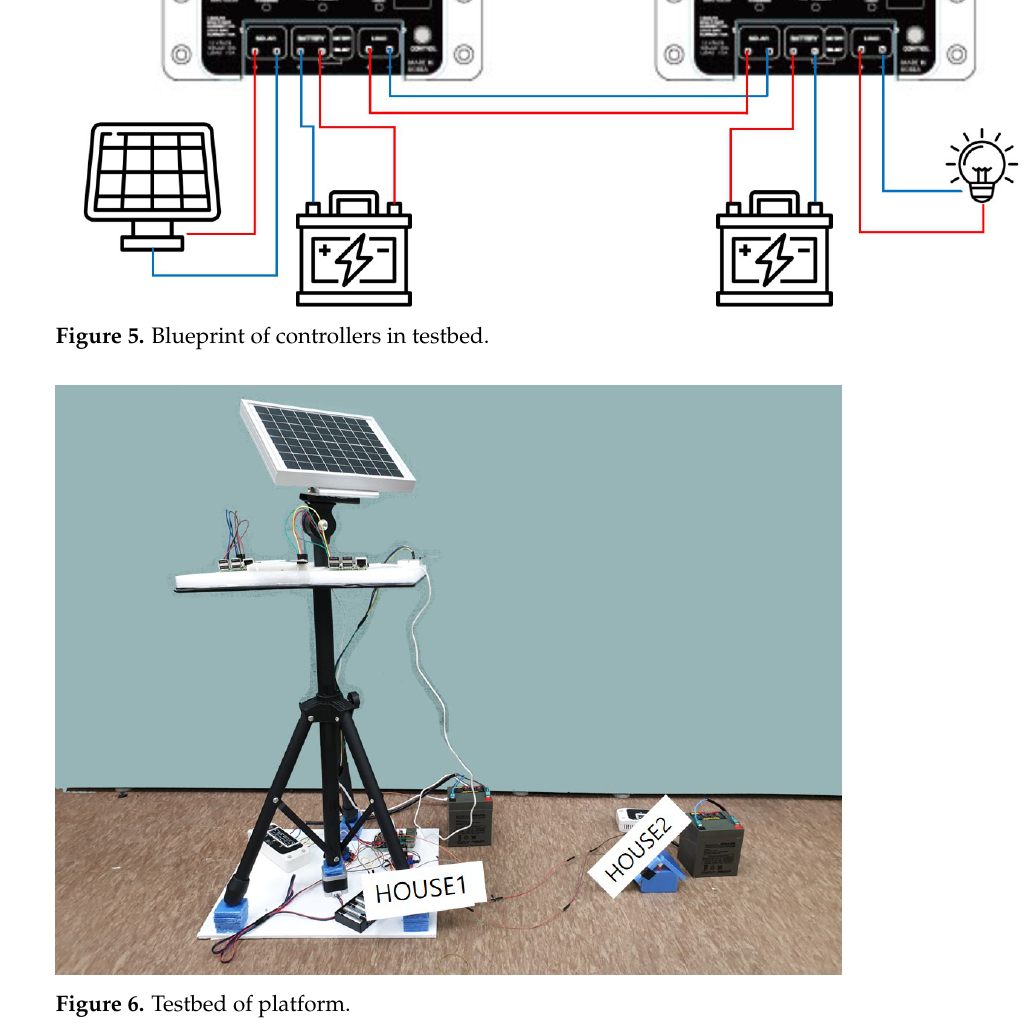
Figure 6. Testbed of